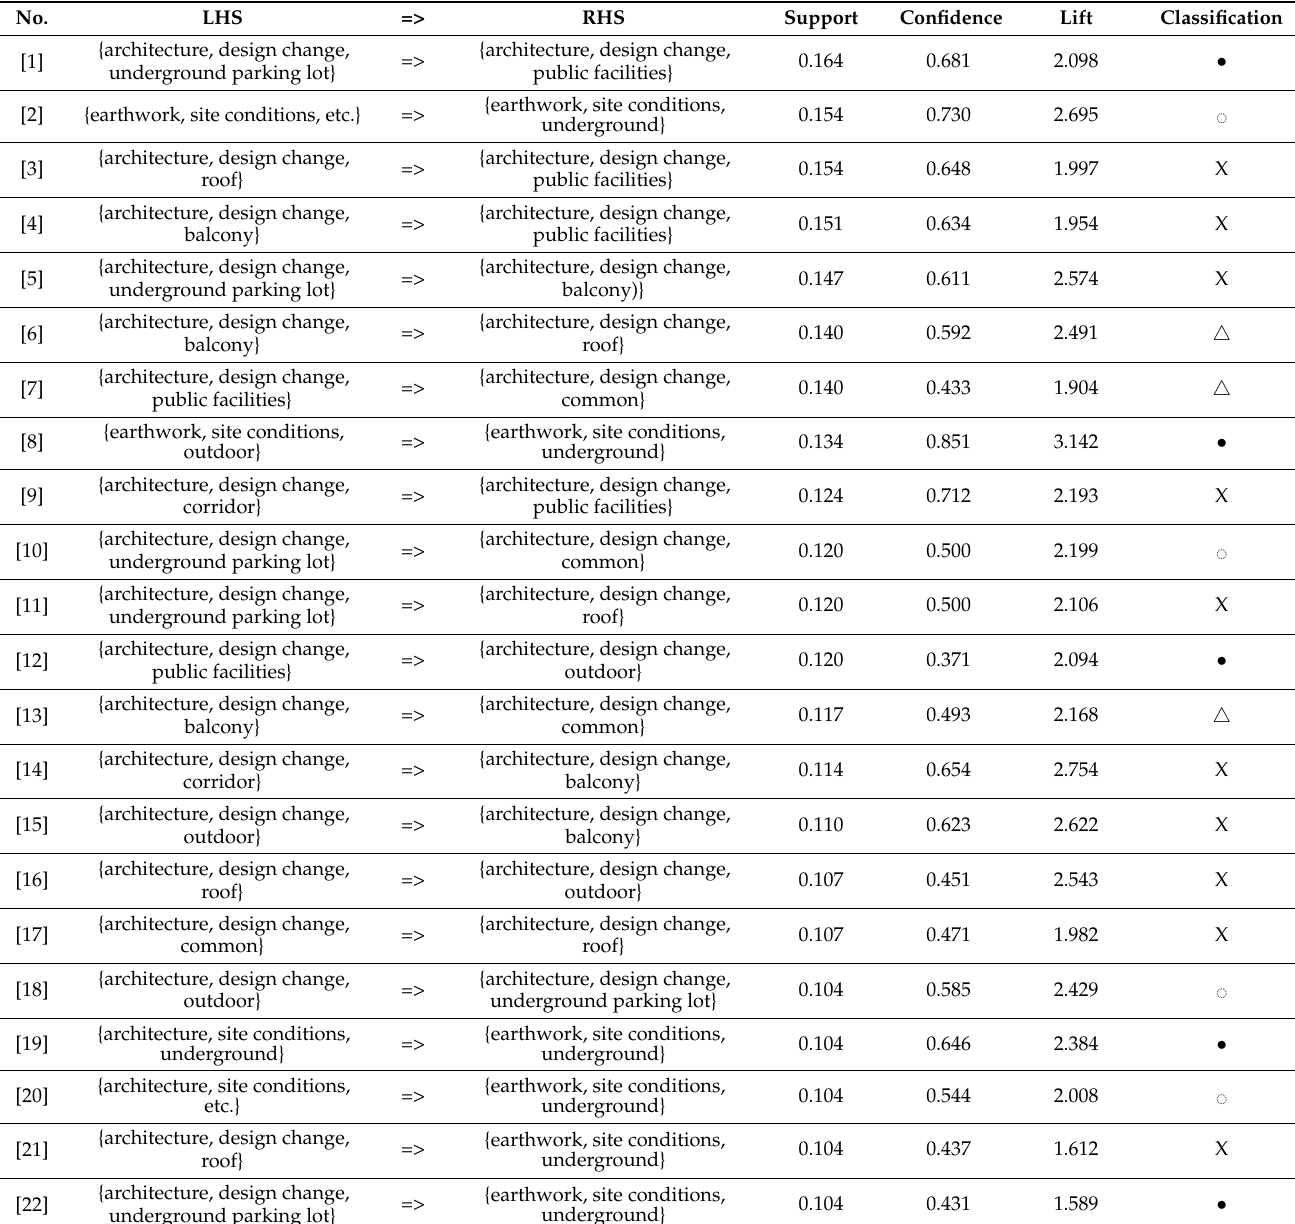
Table 4. Results of derivation of association rules for all design change issue data.